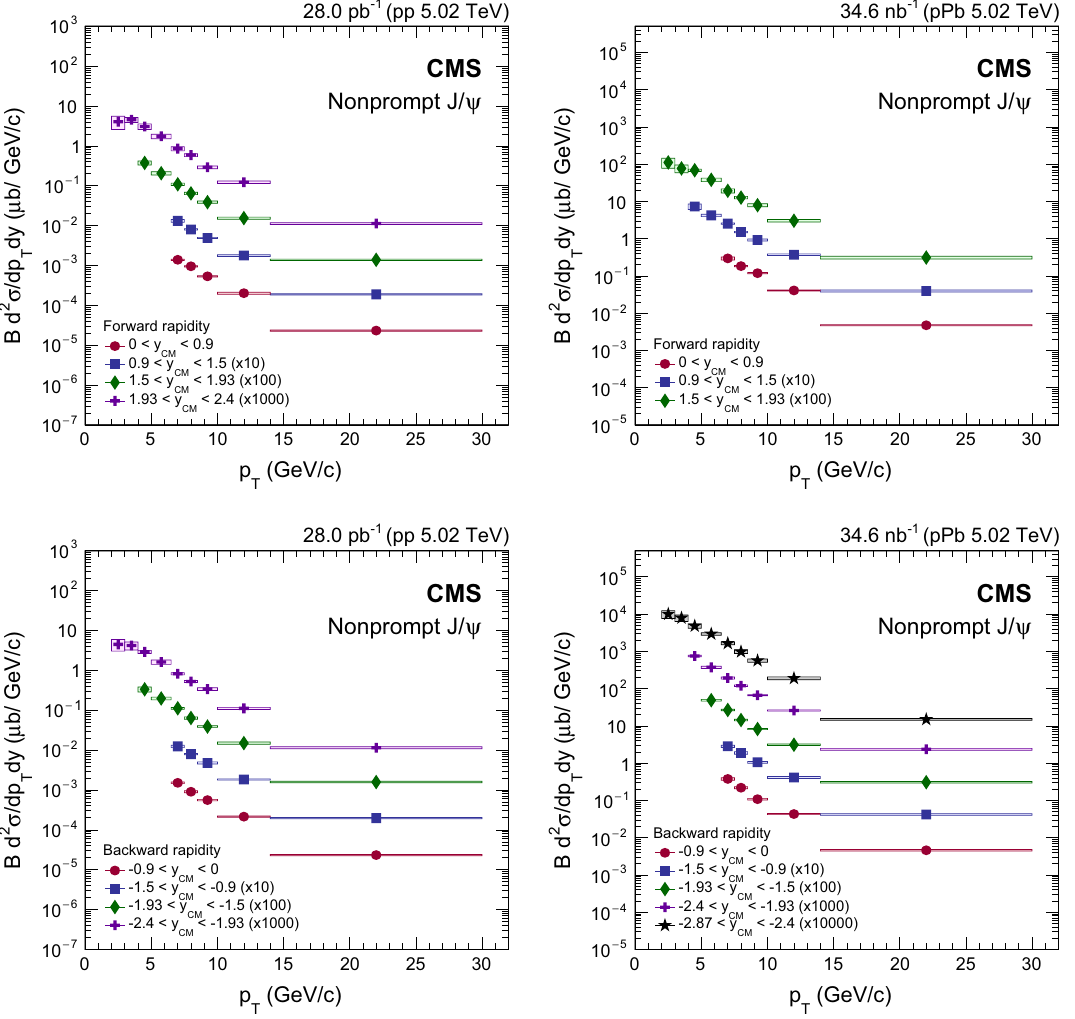
Fig. 8 Differential cross section (multiplied by the dimuon branch- ing fraction) of nonprompt J /ψ mesons in pp ( left ) and pPb ( right ) collisions at forward ( upper ) and backward ( lower ) y CM . The vertical bars (smaller than the symbols in most cases) represent the statistical